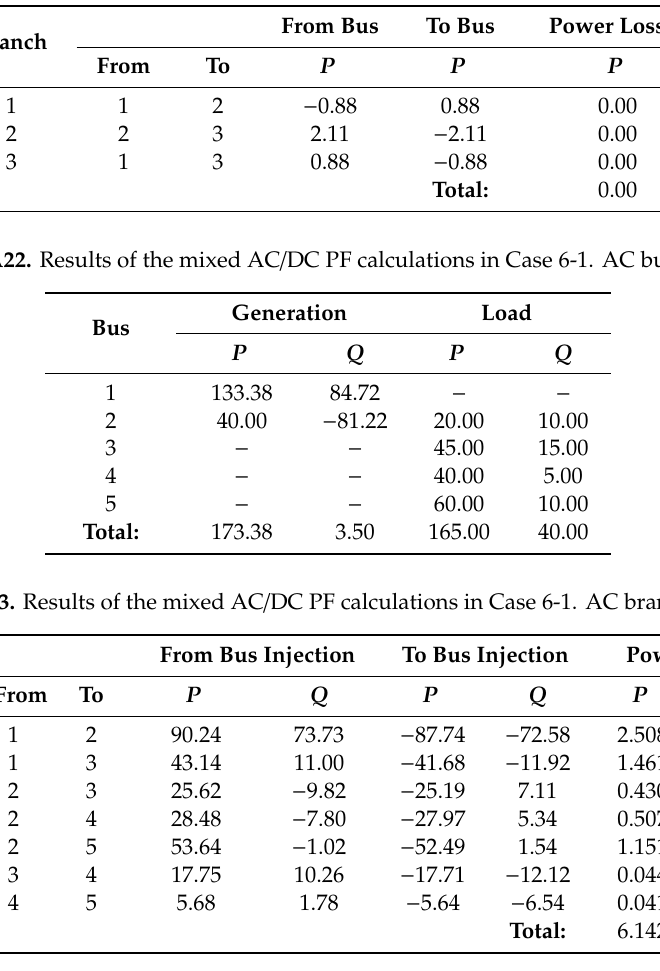
Table A21. Results of the mixed AC / DC PF calculations in Case 5. DC branch data.